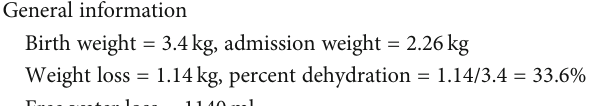
Table 1: Calculation used to correct the fl uid de fi cit. General information